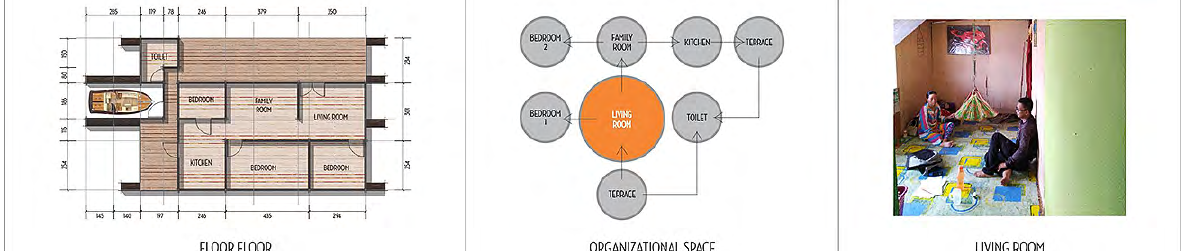
Figure 11. (a) Floor plan case 3; (b) Organizational space case 3; (c) Living room case 3